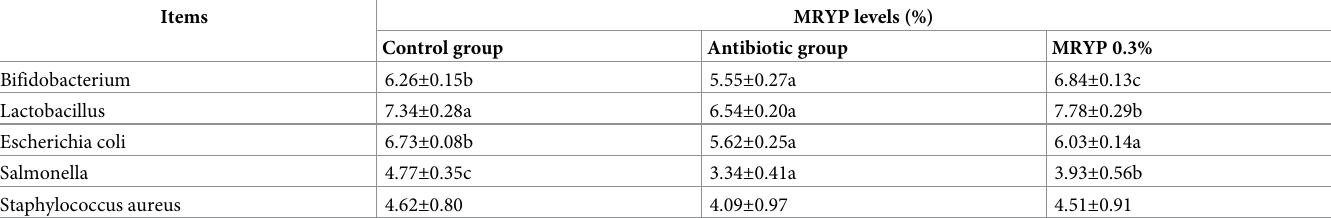
Table 11. Effect of MRYP on five kinds of bacteria in lamb feces (log CFU/g).